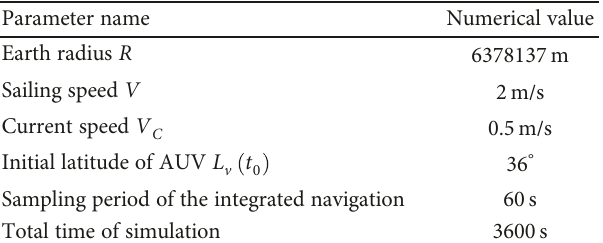
Figure 2: Schematic diagram of the simulation trajectory. Table 1: Simulation